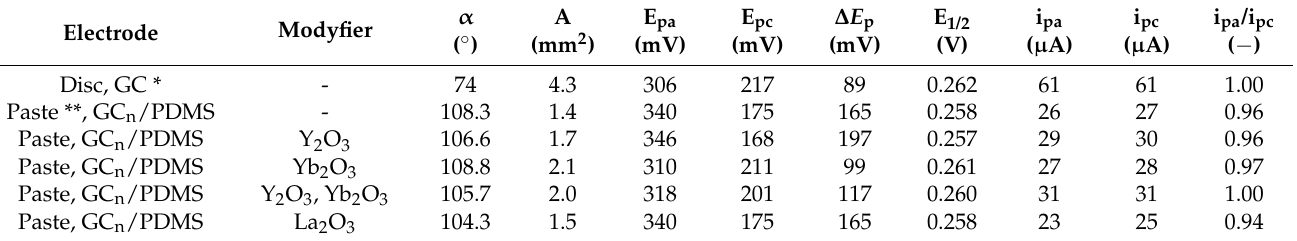
* GC—commercial disc electrode, 3 mm in diameter, geometric area of 7.1 mm 2 ; ** paste electrodes, 2 mm in diameter, geometric area of 3.1 mm 2 .